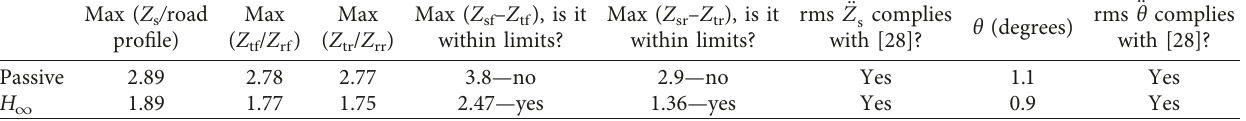
Table 3: Summary of suspensions performance. Unless indicated, all numerical quantities are in cm. Max ( Z s /